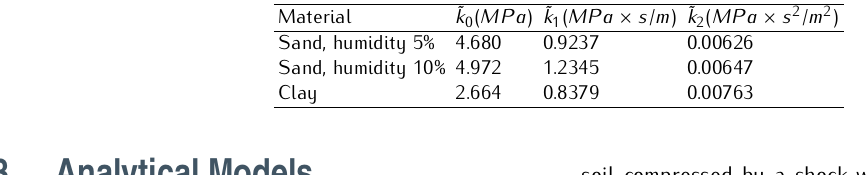
Table 10. Coefficients in Eq. (46) (Khromov